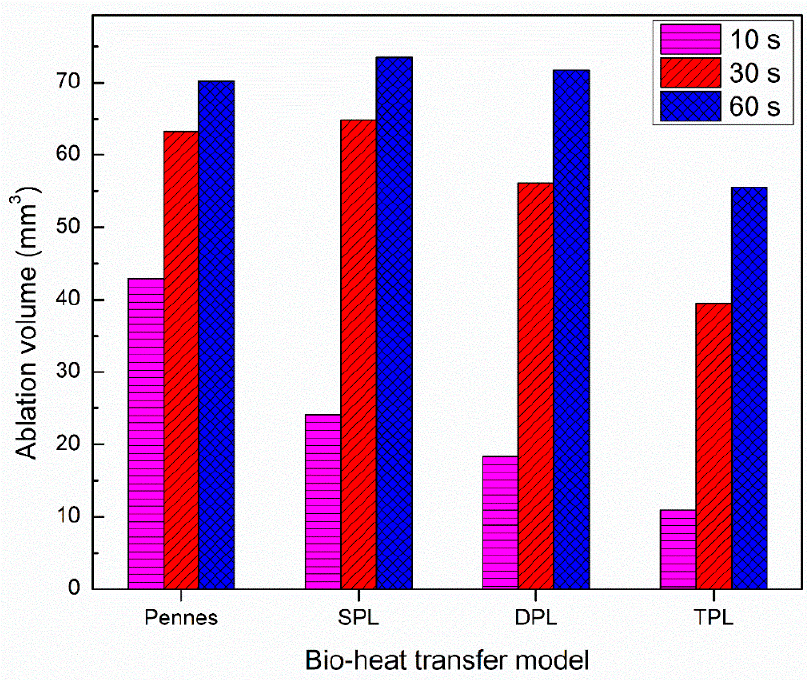
Figure 5. Comparison of the ablation volume predicted with different bio-heat transfer models at 10 s, 30 s, and 60 s of treatment times.